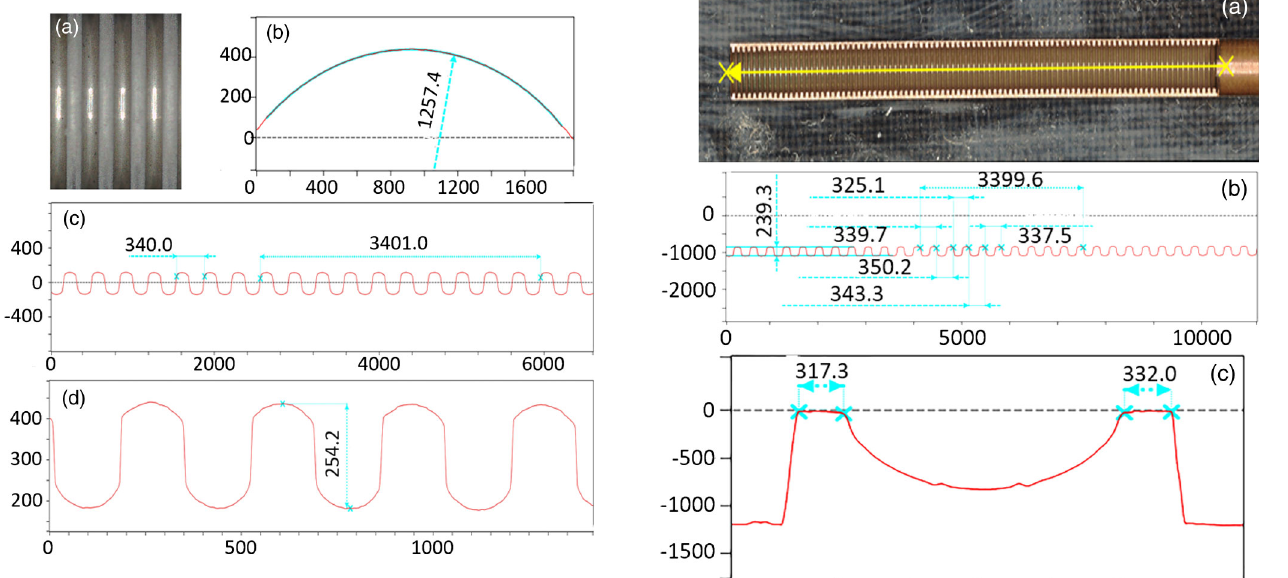
FIG. 4. (a) A fragment of the mandrel viewed under the microscope with a 150 times magnification. (b) Radius profile of the mandrel “ tooth ” that will form the CW “ groove. ” (c) Longitudinal profile of the corrugation indicating uniform periodicity. (d) Corrugation detail indicating groove depth. All dimensions are in microns.